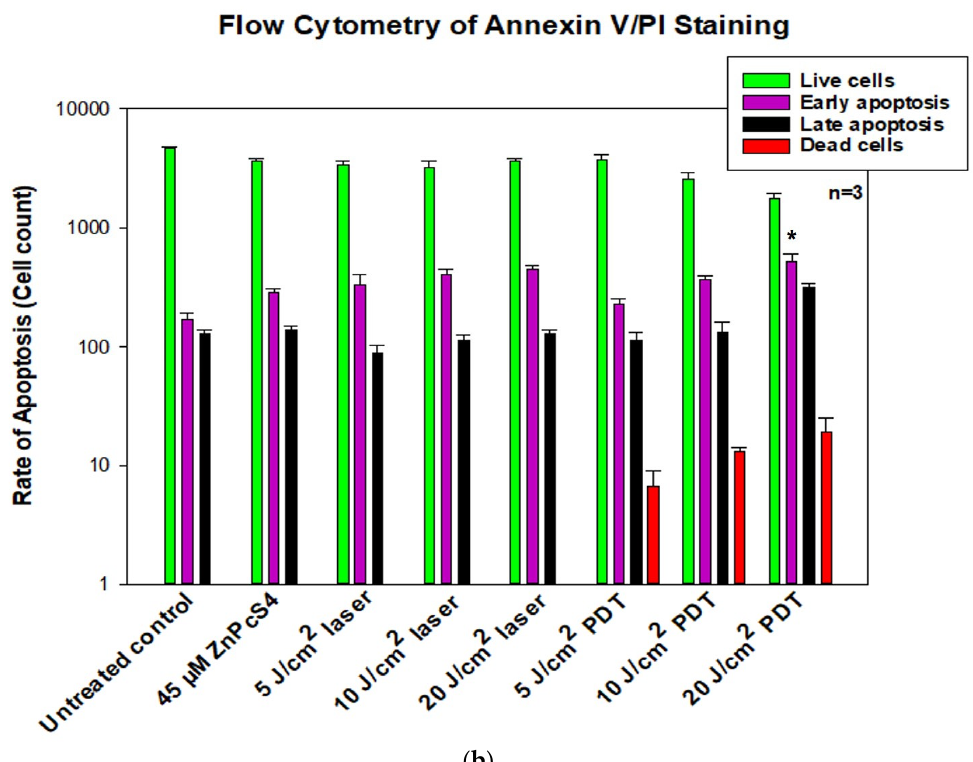
Figure 1. ( a ) Quadrant distribution of MCF-7/DOX cells stained with Annexin V/FITC and PI undergoing apoptosis, dead cells, late apoptosis, live cells, early apoptosis. The MCF-7/DOX control cells used were treated with hydrogen peroxide to induce death (image A ), untreated control cells (image B ), PS alone control (image C ), and laser control difference of 5, 10, and 20 J/cm 2 fluencies for images ( D – F ), respectively. The MCF-7/DOX PDT treated cells are represented in pictures ( G – I ) for 5, 10, and 20 J/cm 2 fluencies, respectively. ( b ) Cell apoptosis was analyzed using flow cytometry after 24 h post-treatment for controls, 5, 10, and 20 J/cm 2 treatment groups. There was a statistically significant difference * p < 0.06 in the rate of cells undergoing early apoptosis between the untreated control and 20 J/cm 2 treated groups. Data are presented as mean ± standard deviation in the representative graphs of different apoptotic phase quadrants of flow cytometry (Figure 1a).